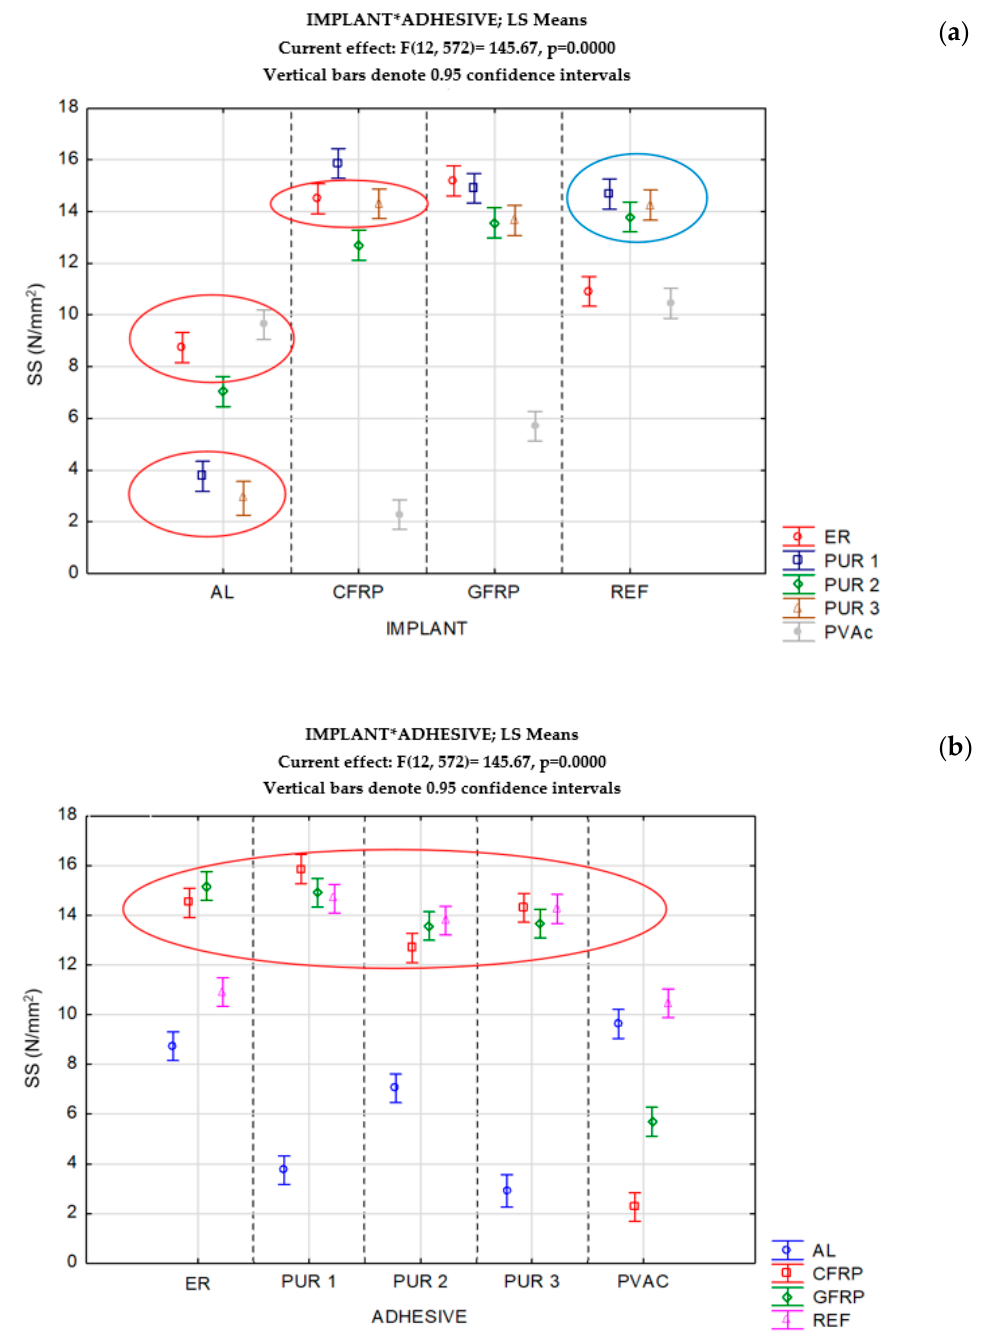
Figure 5. Bondeffectivenessofdifferentcombinationsofimplants( a )andadhesives( b )instandard Figure 5. Bond effectiveness of different combinations of implants ( a ) and adhesives ( b ) in standard conditions.